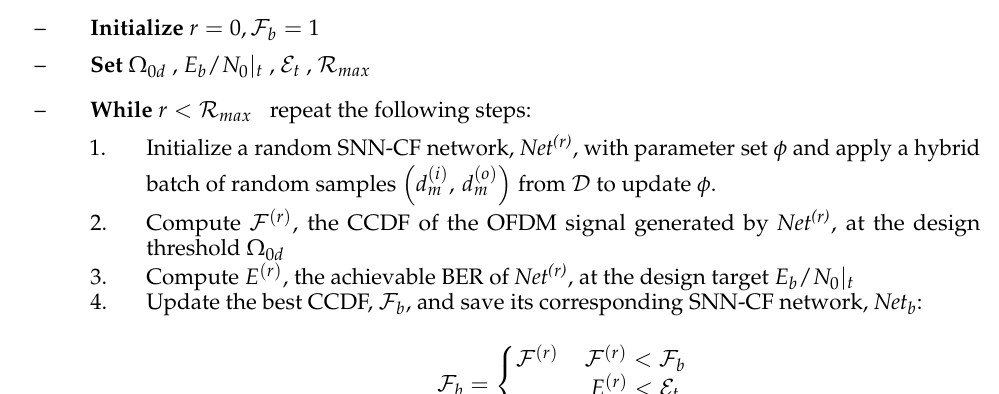
Algorithm 2 : Proposed SNN-CF Network